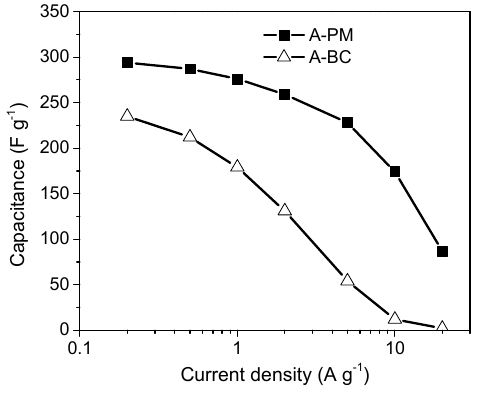
Figure 20. Comparison of the rate capability of ACs produced by KOH activation from pitch mesophase (A-PM) and bituminous coal (A-BC).